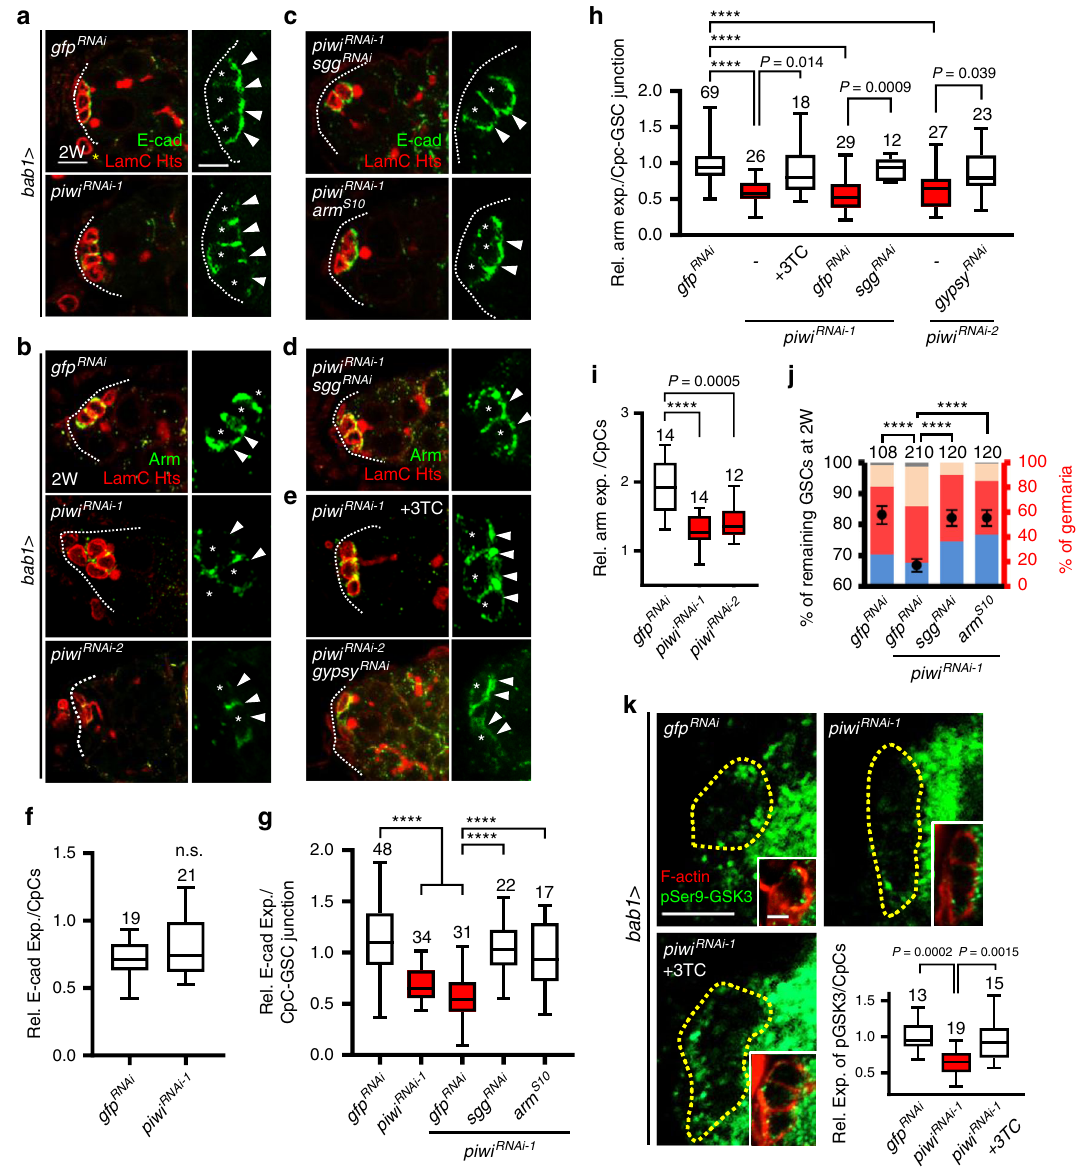
Fig. 3 Retrotransposons increase GSK3 activity to impair niche-GSC anchorage. a , c E-cadherin expression was evaluated at the niche-GSC junction (arrows) of 2-week (W)-old bab1 > piwi RNAi-1 , bab1 > piwi RNAi-1 sgg RNAi , and bab1 > piwi RNAi-1 arm S10 germaria (green, E-cadherin; red , LamC for CpC nuclear envelopes; red, Hts for fusomes). Scale bars in left and right images are 5 and 2.5 μ m, respectively. b , d , e Arm expression in the niche-GSC junction of 2- week-old bab1 > piwi RNAi-1 , bab1 > piwi RNAi-2 , bab1 > piwi RNAi-1 ;sgg RNAi , bab1 > piwi RNAi-2 ;gypsy RNAi , and germaria of bab1 > piwi RNAi-1 with 10 mM 3TC treatment (green, Arm; red, LamC and Hts). Same magni fi cation of images ( a – e , left), and of enlarged images ( a – e , right) share the left and right the scale bar in a, respectively. f , g Relative expression of E-cadherin in the niche ( f ) or niche-GSC junction ( g ) of germaria with indicated genotypes. h , i Relative expression of Arm in the niche-GSC junction ( h ) or niche ( i ) in the germarium of indicated genotypes. j Relative percentage (%) of GSC number in 2-week- old germaria of indicated genotypes (normalized to GSC number at D1). Note that GSC number of gfp RNAi alone are the same data as shown in Fig. 1d. % of germaria (Right y -axis) indicates the proportion of 2-week-old germaria carrying 0, 1, 2, and 3 or 4 GSCs. k pSer9-GSK3 β expression in the niche of 2- week-old bab1 > gfp RNAi and bab1 > piwi RNAi-1 germaria with or without 10 mM 3TC treatment (green, pSer9-GSK3 β ; red, F-actin for CpC plasma membranes). Scale bars, 5 μ m; all inset images in k are same magni fi cation (scale bar, 2.5 μ m). Dashed line, the anterior edge of the germarium ( a – e ); asterisks, CpCs; dashed circles outline niche CpCs ( k ). Box-Whiskers plots ( f , g , h , i , and k ) show the central lines for median values, edges of box represent upper (75th) and lower (25th) quartiles and whiskers show minimum and maximum values. Numbers of analyzed niches/niche-GSC junctions and GSCs are shown above or within each bar ( f – k ). Error bars, S.E.M. in j . Statistical analysis, Student ’ s t -test for f and j ; One-way ANOVA for g , h , i , and k . **** P < 0.0001. At least two biological replicates were performed for each